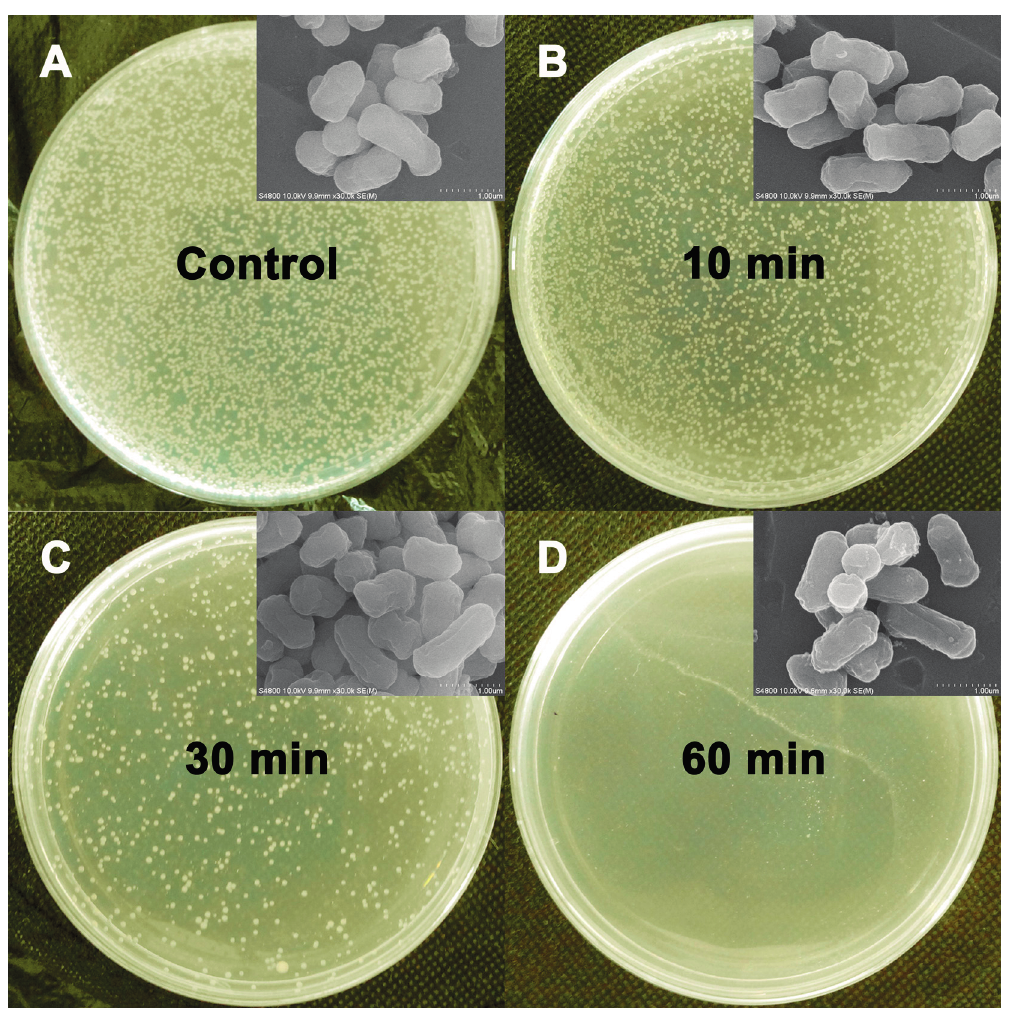
Figure 4. Photographs showing the bacterial culture plates of E. coli upon the exposure to the control ( A ) and SiO 2 @PS/ N -halamine NPs (2.37% of the oxidative chlorine